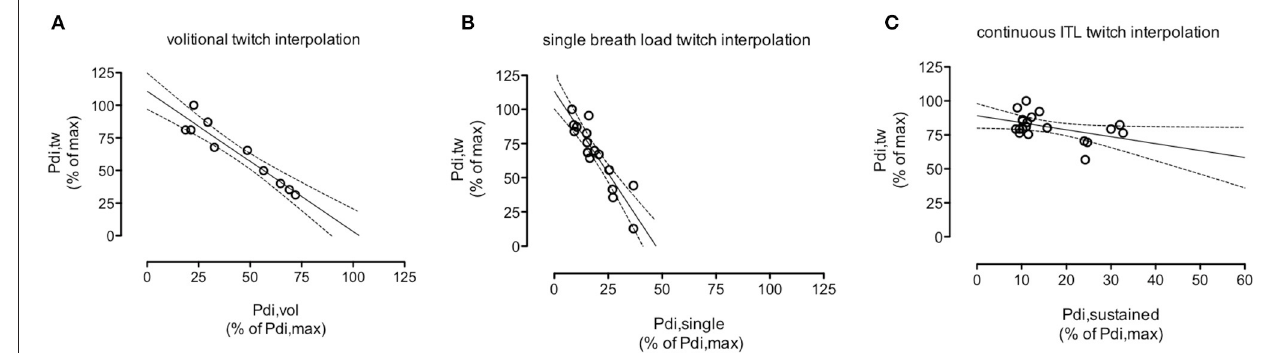
FIGURE 2 | Example, in one subject (#4), of the course of the twitch transdiaphragmatic pressure (Pdi,tw) elicited by cervical magnetic stimulation as a function of the intensity of the underlying diaphragm contraction. (A): voluntary effort; (B) : non-volitional “single-breath” effort in response to the first presentation of an infinite resistance. (C) : non-volitional "continuous" effort, 10 breathing cycles after application of an inspiratory threshold load (ITL). The intensity of the underlying diaphragmatic contractions (abscissa) is expressed as a percentage of the maximal transdiaphragmatic pressure measured by static manoeuvres (Pdi,max). Pdi,tw (ordinate) are expressed as a percentage of their maximal values measured during the procedure considered. Solid lines depict the linear regression, dotted lines depict the corresponding 95% confidence interval. Note that the “continuous ITL” scales differ from the other scales because of the threshold load range (0 to 45 cm H 2 O). In the subject that this figure depicts, panel B shows that a diaphragm contraction producing a Pdi amounting to about 50% of the maximal Pdi recorded during voluntary contractions corresponded to near maximal diaphragm activation (phrenic stimulation triggered by higher pressure did not produce further pressure increments). In other words, the recruitment of phrenic motoneurons required to produce a given pressure was greater during the “single breath” procedure than during the voluntary procedure. During the “continuous ITL procedure” (C), we needed the subjects to be able to breathe in sustainedly, and therefore the inspiratory limb of the breathing circuit could not be occluded. We chose inspiratory threshold values in a reasonable range regarding the induced respiratory discomfort. What (C) shows is that the Pdi,tw value corresponding to about 35% of Pdi,max is twice higher than the Pdi,tw value corresponding to the same percentage of Pdi,max during the “single breath” procedure (B) . This supports our hypothesis of a differrent dynamica of phrenic motoneurons recruitment between single breath loading and sustained loading.